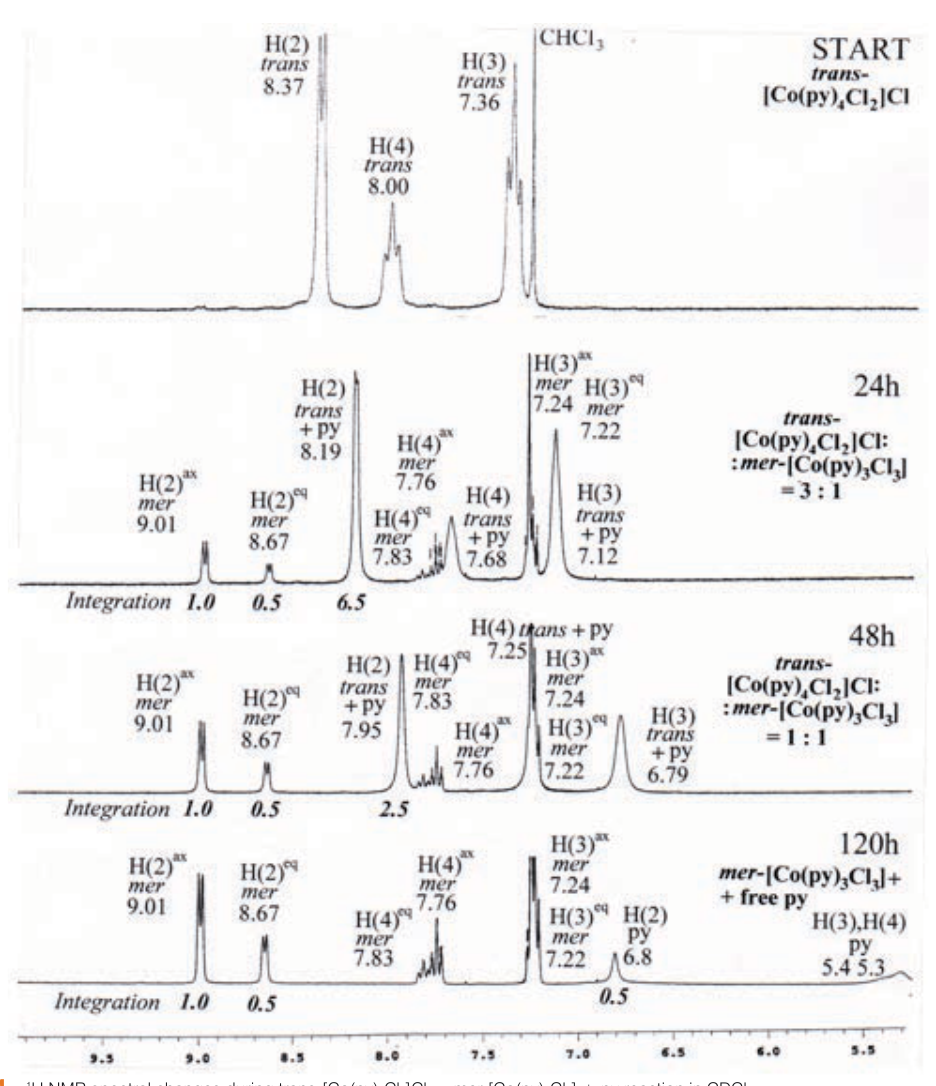
Cl ]Cl → mer-[Co(py) 4 2